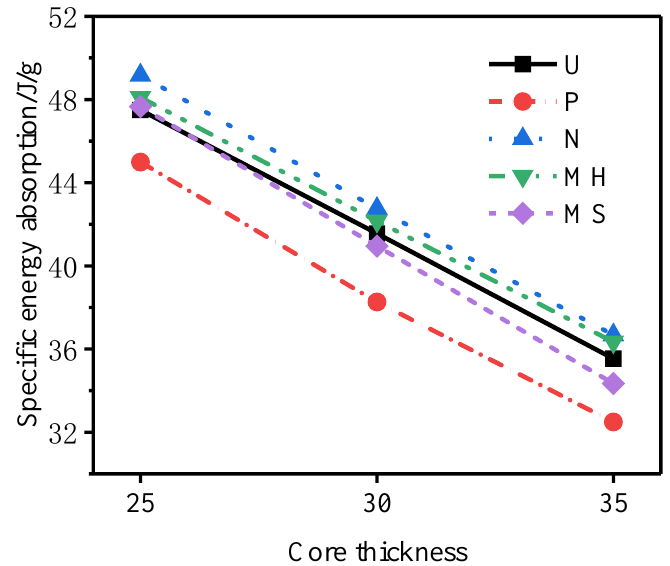
Figure 26. Core specific energy absorption of sandwich tubes with different core thicknesses.